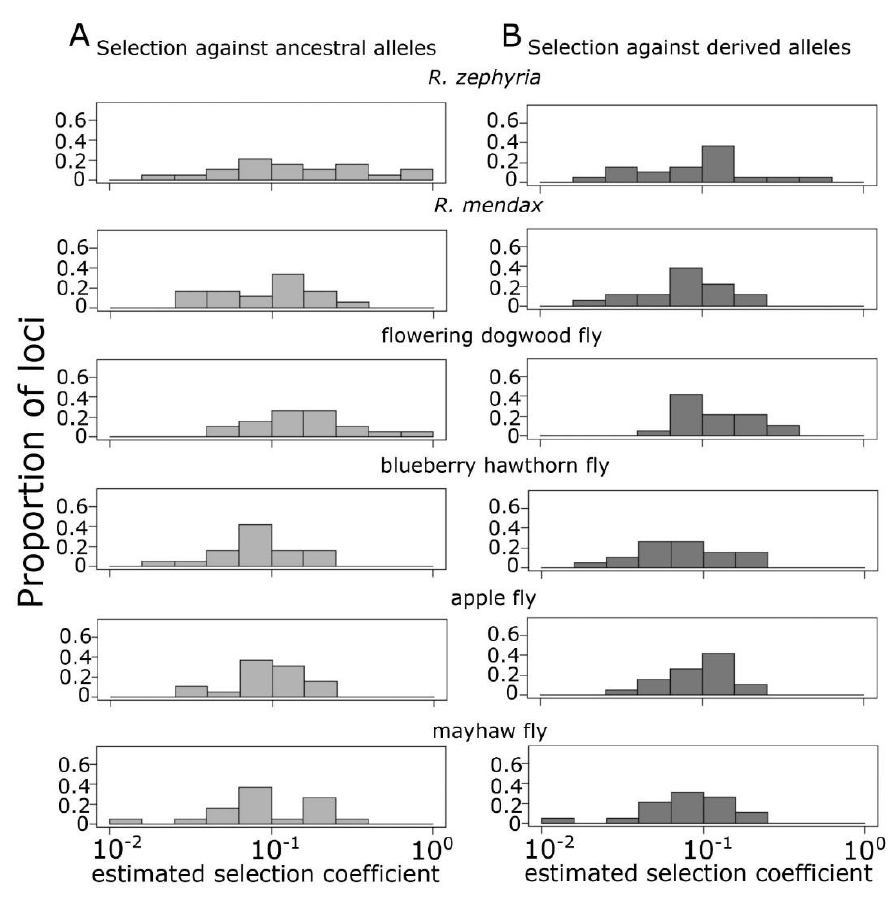
Figure 4. Distribution of estimated selection coefficients needed to maintain observed frequency differences between microsatellite allele classes under gene flow for each pairwise sympatric comparison. ( A ) Estimated selection coefficients against ancestral (hawthorn) allele in populations of the derived taxa and ( B ) estimated selection coefficients against allele favored in the derived population in the sympatric hawthorn population.